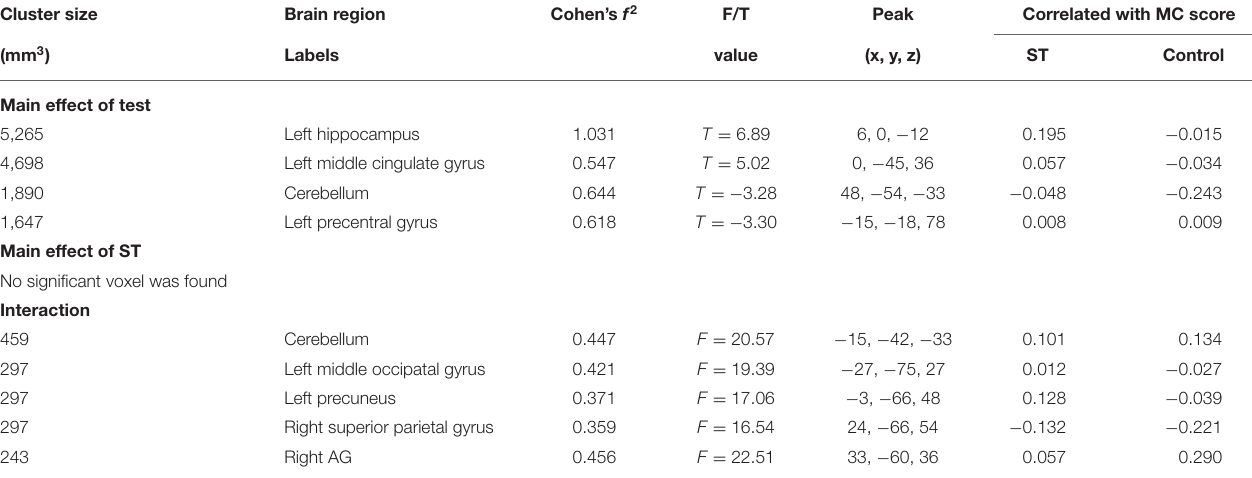
TABLE 3 | The brain regions that were significant in the mixed-effect analysis of the weighted graph. Cluster